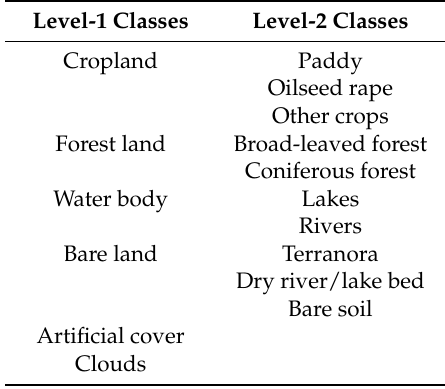
Table 1. Classification scheme for land cover types.